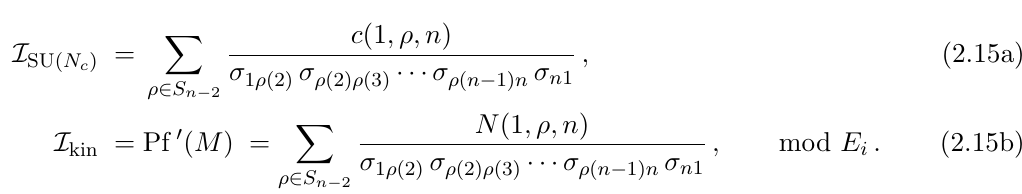
Figure 2 . Example at 4 points of how a diagram relates to master diagrams via Jacobi relations. This equation applies to both the colour factors and (by de(cid:12)nition) the BCJ numerators associated to the